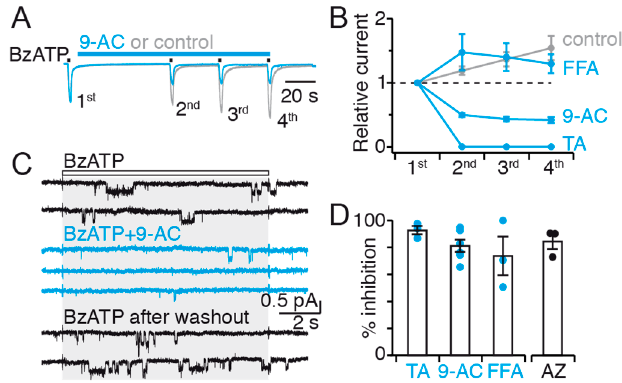
Figure 3. TA and 9-AC prevent current facilitation and inhibit single-channel activity. ( A ) Whole-cell currents evoked by repeated 2 s applications of 10 μ M BzATP in the presence (blue) or absence of 9-AC (grey) in HEK293T cells transiently expressing rP2X7. Currents are normalized to the first application. ( B ) Summary of currents relative to the first application in the absence (control) or presence of inhibitors ( n = 4 cells for TA, 10 for 9-AC, 8 for FFA, and 8 for control). Symbols represent mean ± SEM. ( C ) Single-channel rP2X7 currents elicited by 10 μ M BzATP from an outside-out patch of HEK293T cell (black traces) are inhibited by 1 mM 9-AC when co-applied with 10 µ M BzATP (blue traces). Shown sweeps were sequentially recorded from the same patch. Note that inhibition is reversible after washout. Duration of application is indicated by the white bar and grey shading. Data were filtered at a final f c of 100 Hz. ( D ) Summary of single-channel inhibition ( n = 3 patches for TA, 6 for 9-AC, 3 for FFA, and 3 for AZ10606120). Bars represent mean ± SEM. See Materials and Methods for calculation. Inhibitor concentrations were 20 µ M TA, 1 mM 9-AC, 100 µ M FFA and 1 µ M AZ10606120. Single-channel and whole-cell data were recorded at − 120 and − 60 mV,